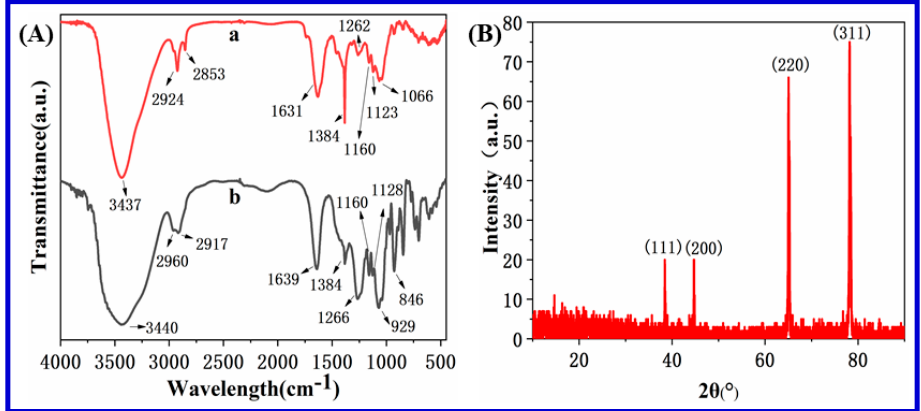
Figure 3. ( A ) FT-IR spectrums of carrageenan (a) and carrageenan-AgNPs (b), ( B ) XRD patterns of carrageenan-AgNPs.